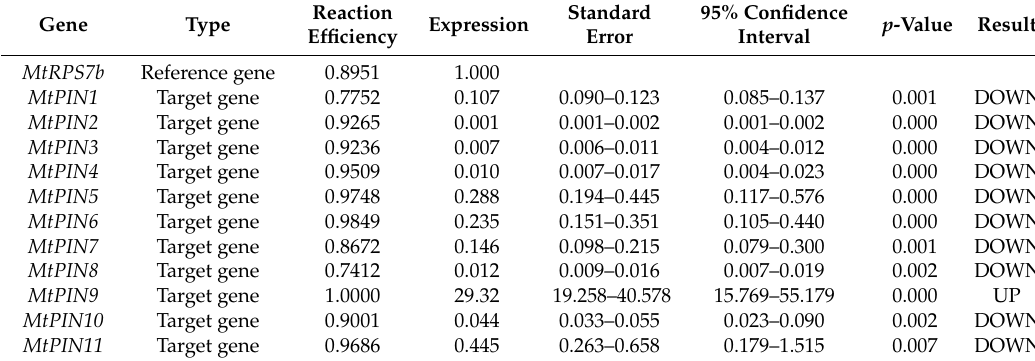
Table 2. Comparison of MtPINs expression pattern in root nodules relative to root tips. Statistical analysis was conducted in LinRegPCR [26] and REST2009 [27]. MtRPS7b , encoding ribosomal protein S7, was used as the endogenous reference gene. “DOWN” or “UP” means that particular MtPIN ’ s expression in nodules in comparison to root tips is significantly lower or higher,